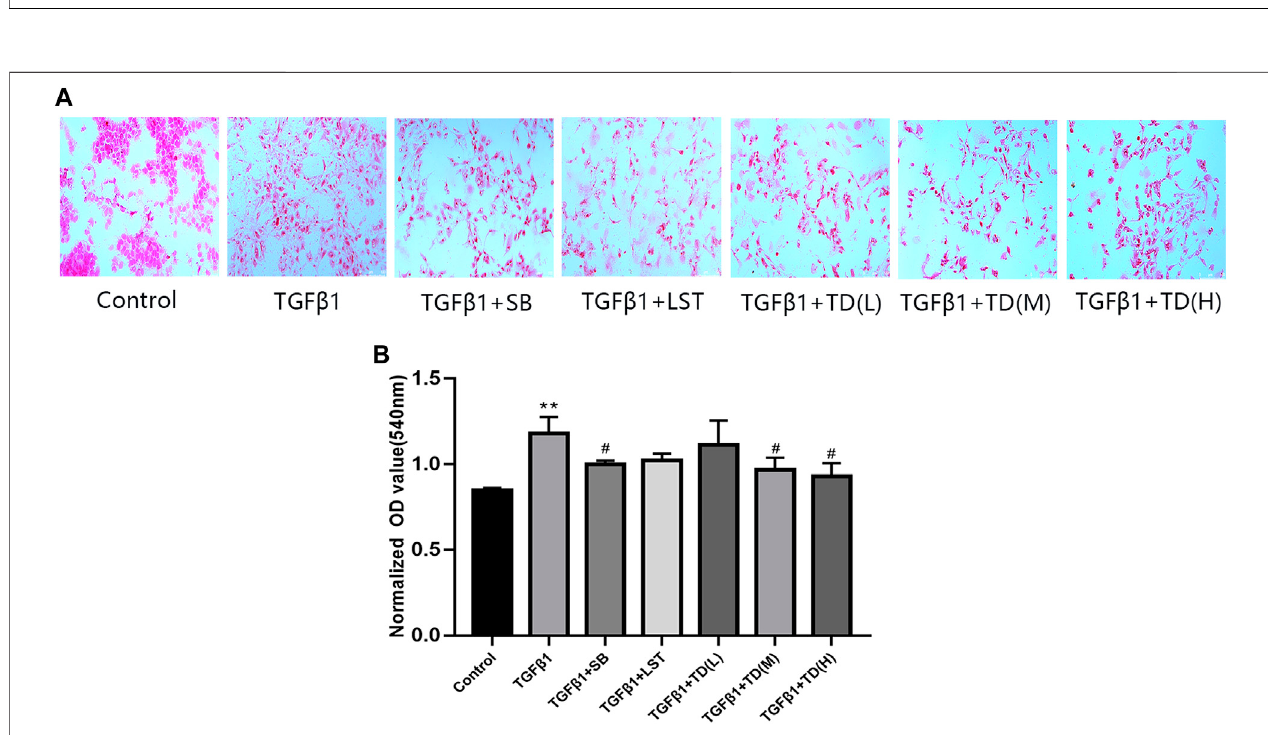
FIGURE 8 | Effect of TDC on collagen deposition of TGF- β 1-treated HEK293 cells (A) Representative image of Sirius red staining ( × 200 magni fi cation), with red representing collagen deposition. SB: positive-control drug TGF- β 1 inhibitor SB431542 (5 μ mol/l); LST: losartan (1 μ mol/l); L-TDC: low dose of TDC (0.0138 mg/ml); M-TDC: medium dose of TDC (0.0553 mg/ml); H-TDC: high dose of TDC (0.2212 mg/ml) (B) Quantitation of Sirius red staining results from three independent experiments. Data are expressed as mean ± SD, n (cid:2) 3. ** p < 0.01, vs. Control; # p < 0.05, vs. TGF- β 1 induced HEK293 cells.